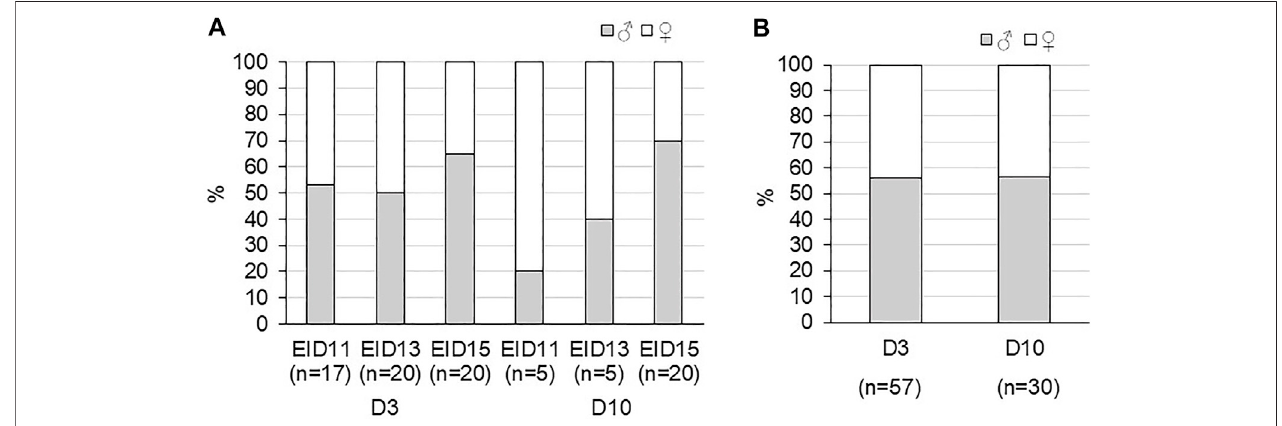
FIGURE 5 | Sex ratio of fertilised eggs during incubation after three or 10 days of storage (D3 and D10, respectively) after 11 (EID11), 13 (EID13) and 15 (EID15) days of incubation. (A) . Sex ratio at each stage of incubation. (B) . Sex ratio in D3 and D10 groups (considering all EID11, EID13 and EID15 eggs).